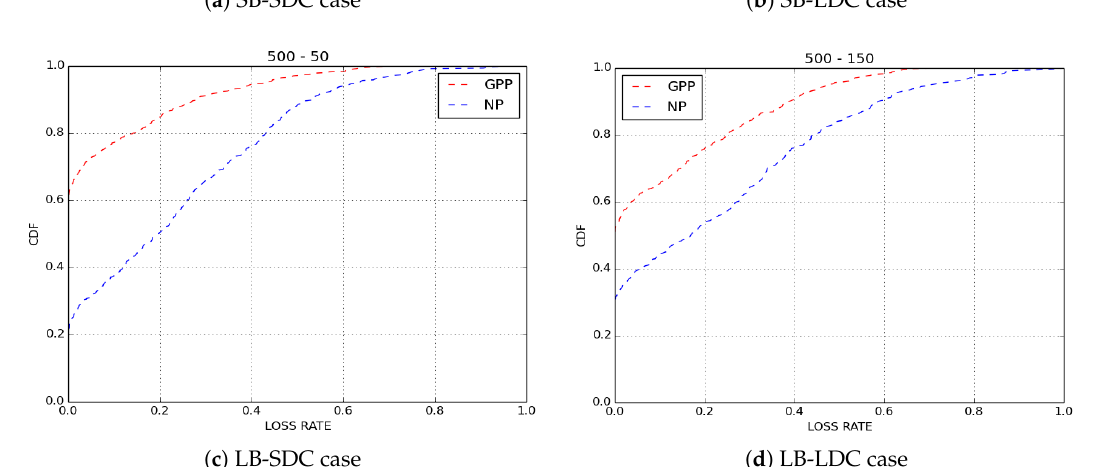
Figure 7. Average loss rate.